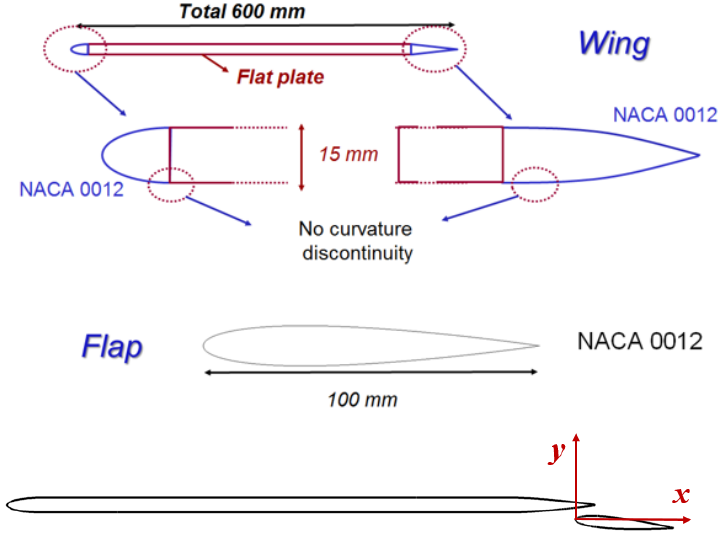
Figure 1. Schematic diagram of wing and flap configuration.